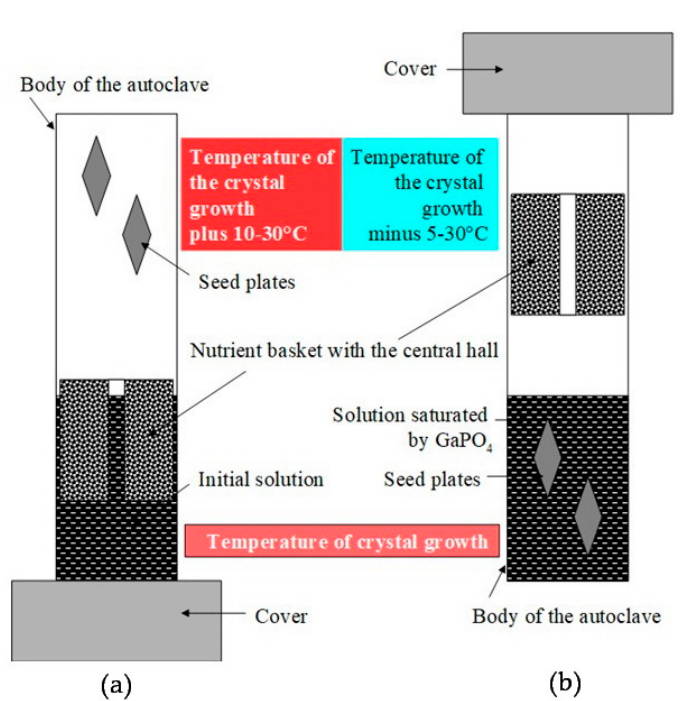
Figure 11. Runs sketch, saturation of the initial solution and further growth of GaPO 4 crystals in the same run cycle. ( a ) First part of the run, autoclave is installed with the seeds on the top and nutrient– in the down; ( b ) second part of the run: autoclave is turned over, the seeds take a place in the saturated solution and the nutrient remains above.